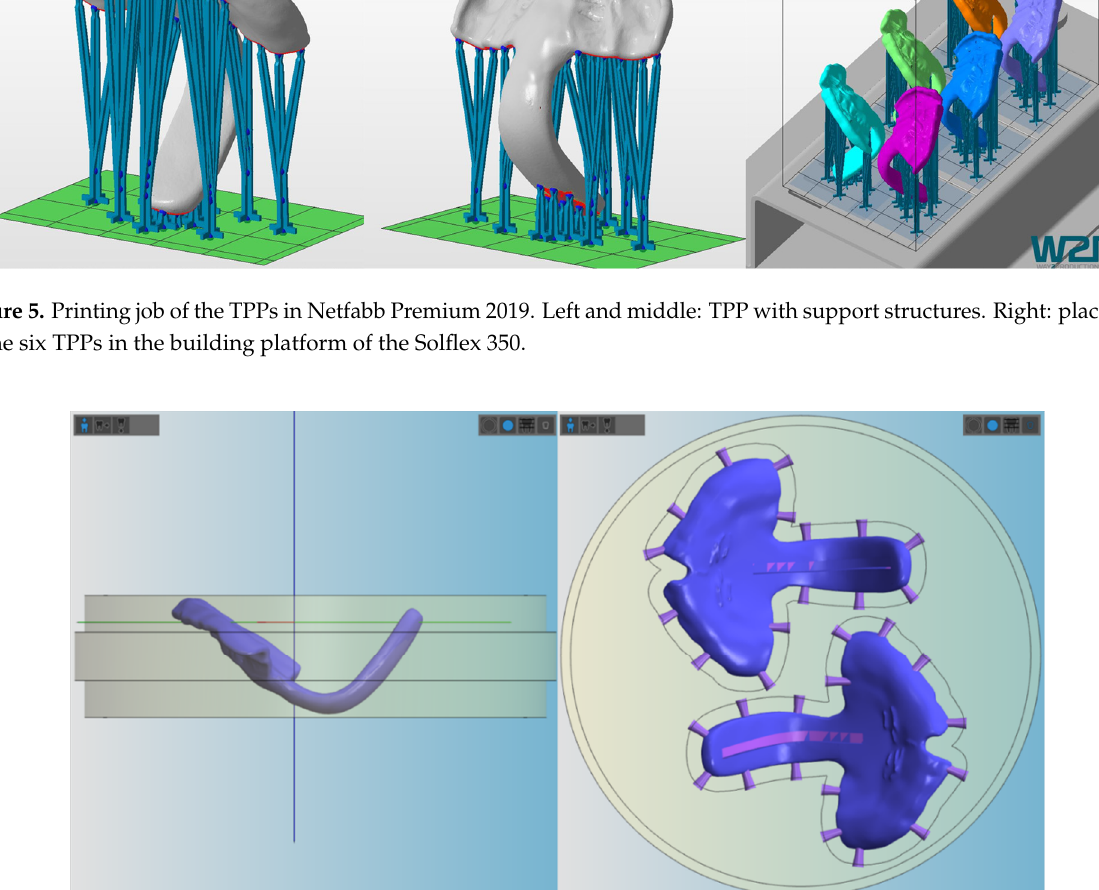
Figure 6. Placement of the TPP (with groove) in the blanks for milling in vhf Dental CAM. Left: positioning of the sample in the lateral view. Right: positioning of the samples from the top, where the connectors are shown.